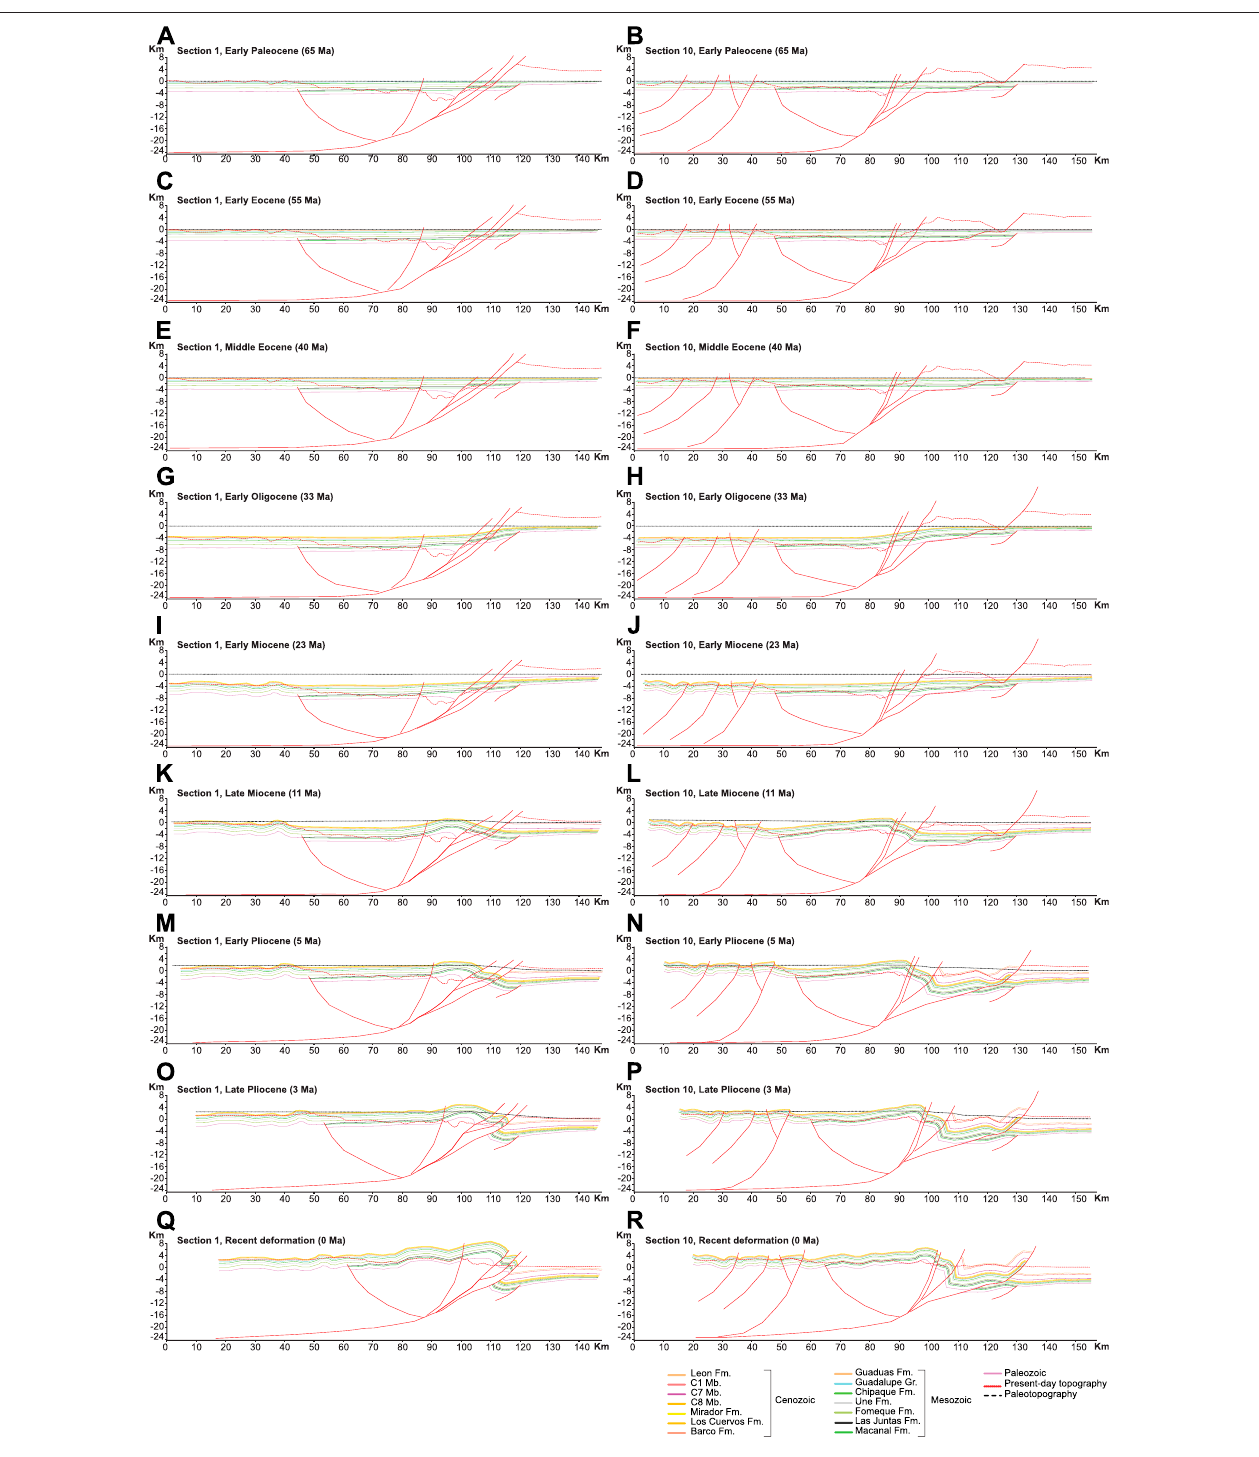
FIGURE 10 | Sequential restoration in nine evolutionary stages, from ∼ 65 Ma to Recent, of Section 1 and 10. From Early Paleocene to Late Eocene the post-rift tectonicsfacilitatedtheaccommodationspaceforthedepositionofthePaleogeneunits.From ∼ 33 MatoRecentthestudyareaexperiencedpositiveinversiontectonics.